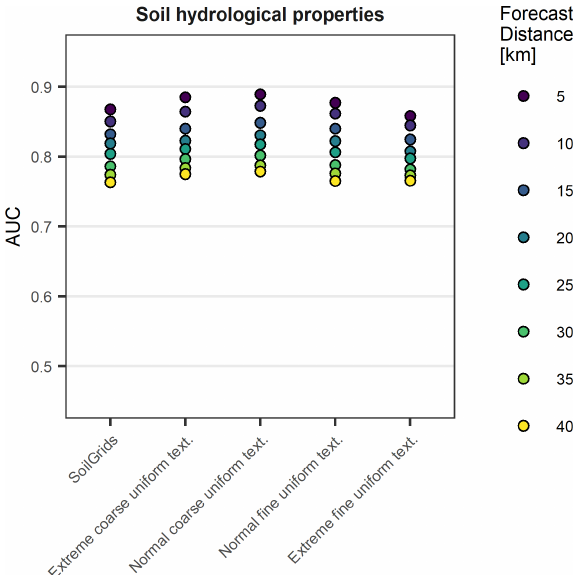
Figure 8. AUC values of landslide forecast model fits based on CoupModel set-ups with varying soil hydrological properties (de- rived from SoilGrids and uniform texture profiles) and a lower boundary condition with